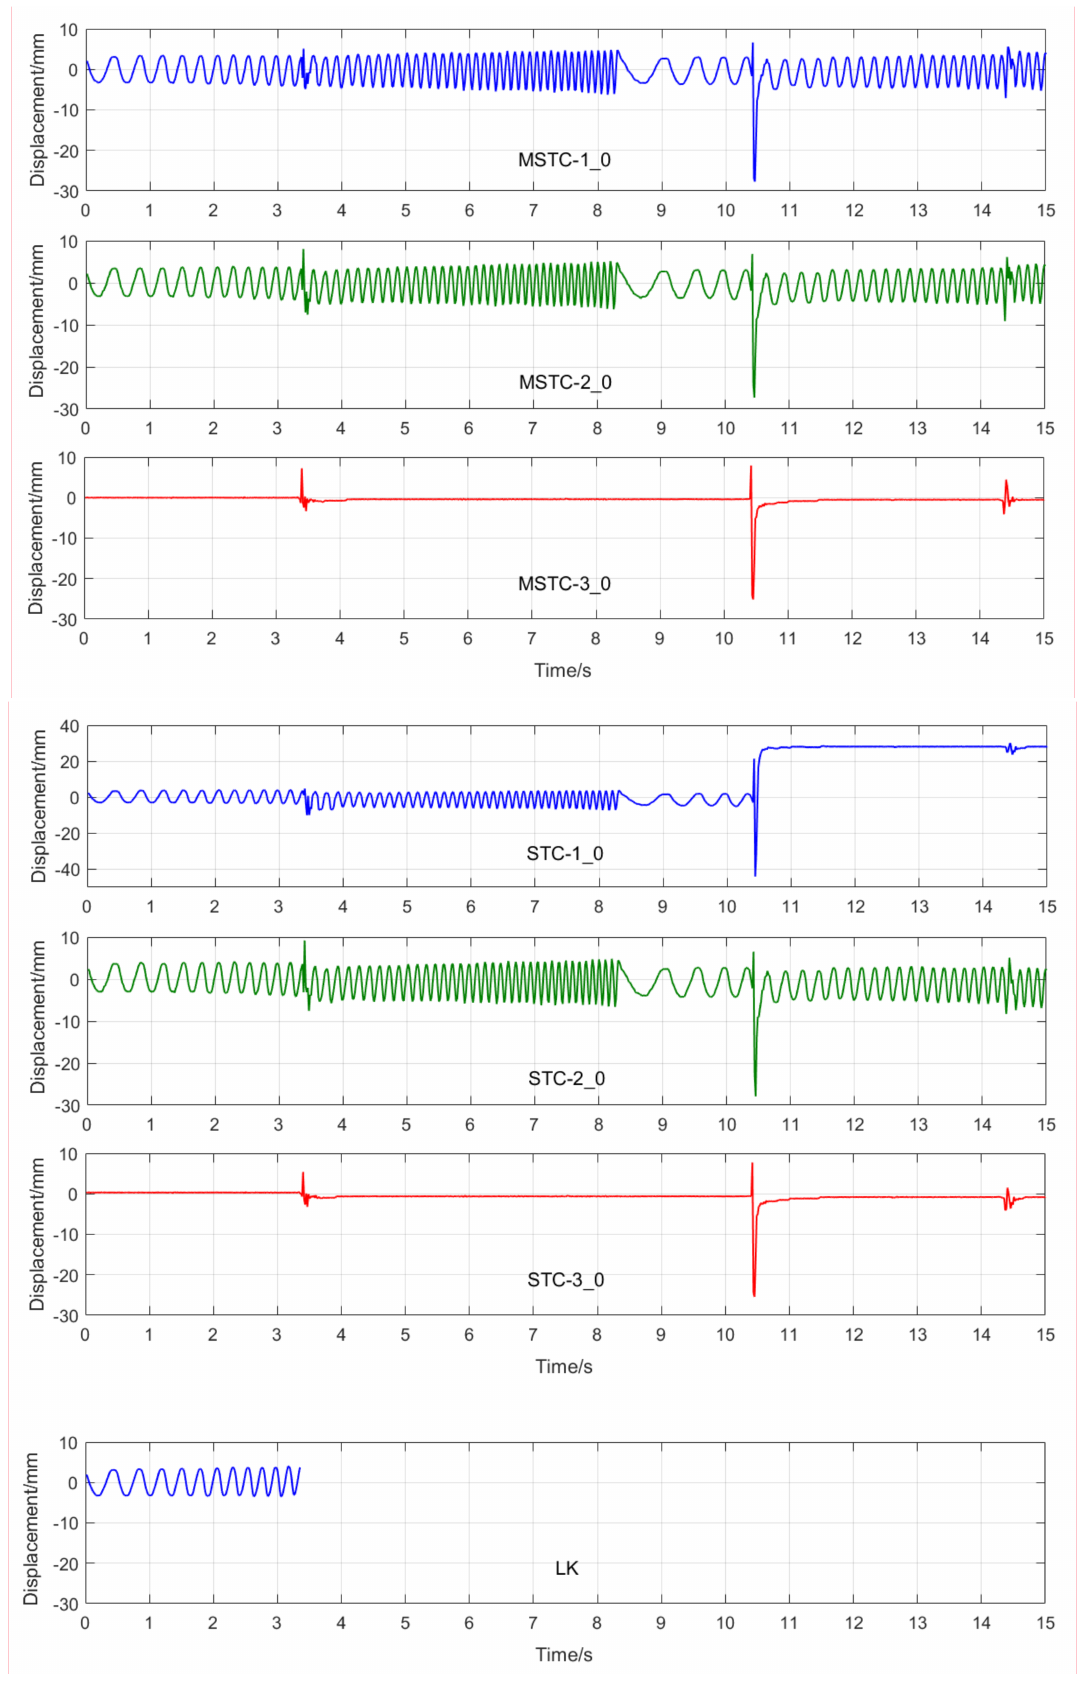
Figure 20. Overall measurement time history and local amplification in Scenario